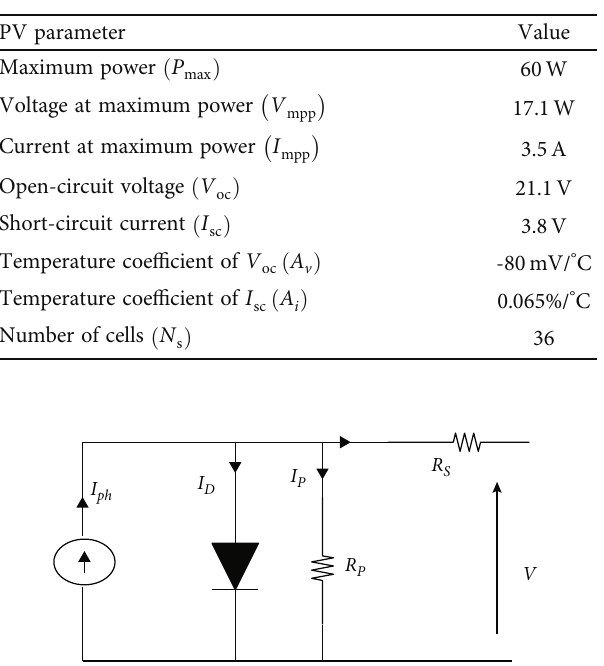
Figure 3: Single-diode equivalent circuit of the solar cell